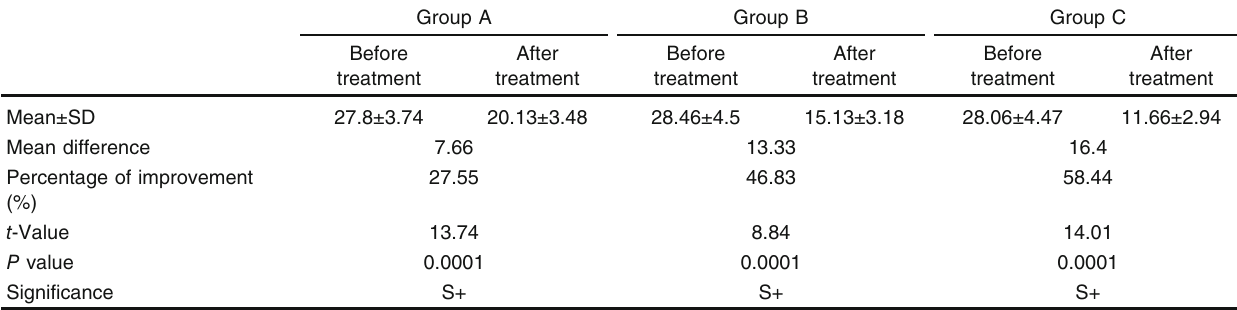
Table 2 Mean and±SD, t -value and P value of the pretreatment and post-treatment values of the neck disability index of groups A, B, and C